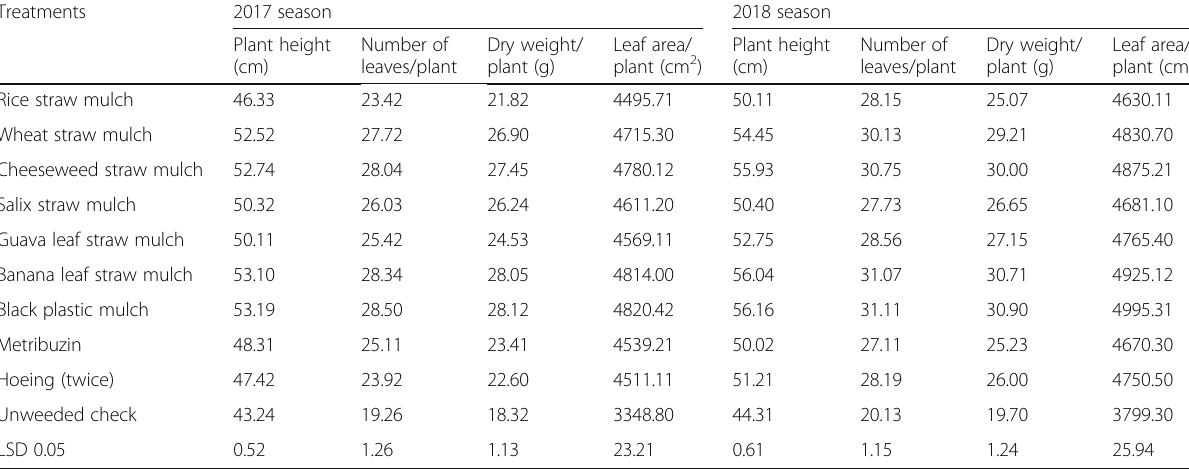
Table 3 Effect of different weed control treatments on vegetative growth traits of potato plants after 70 days from planting